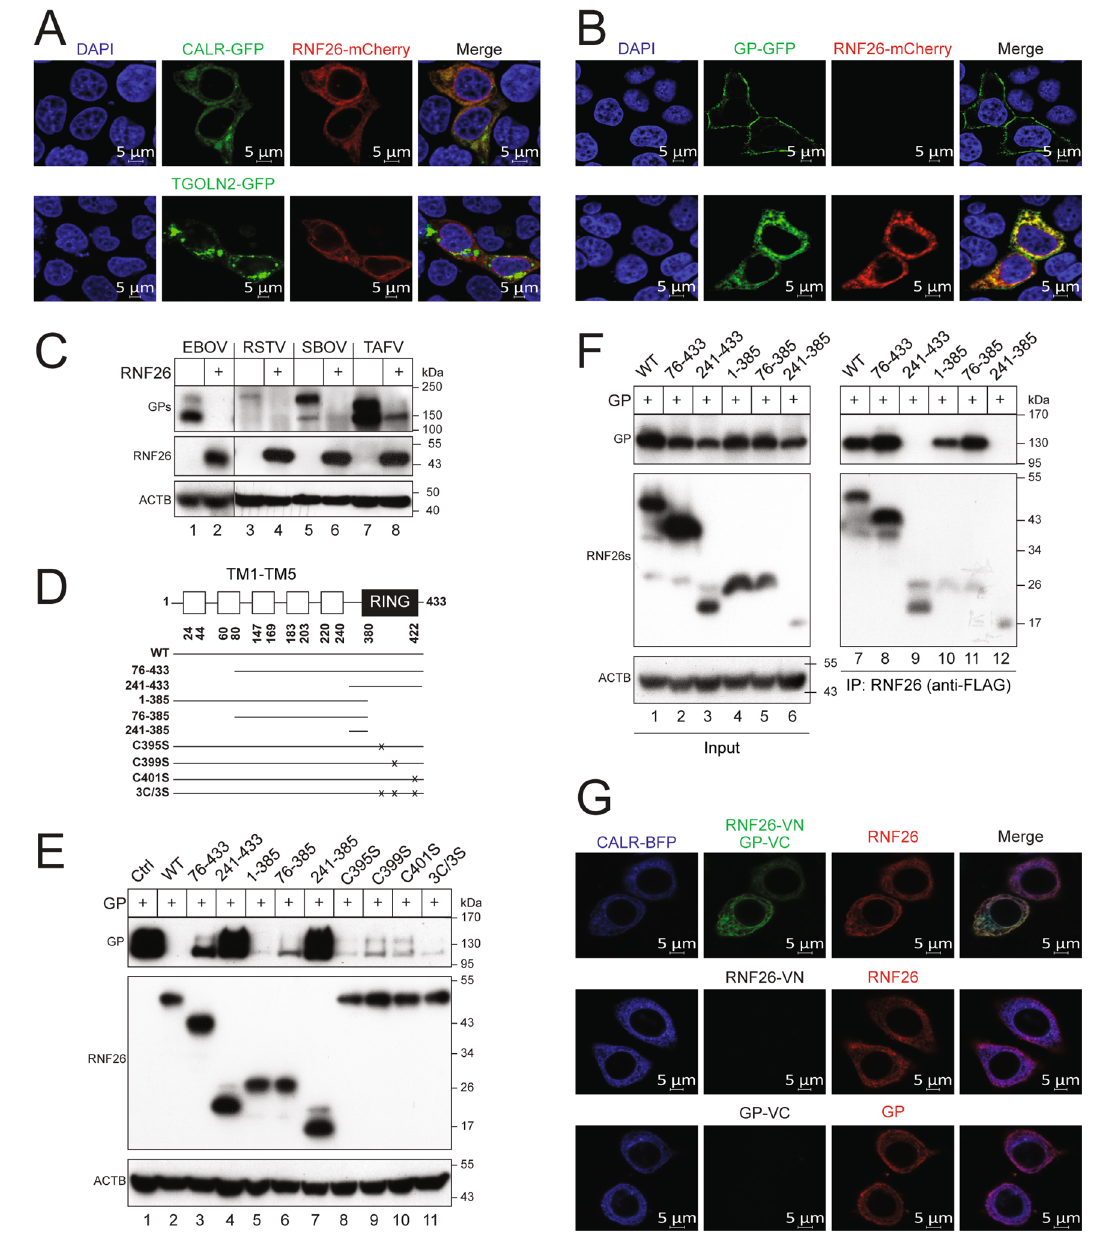
Fig. 5 | RNF26 decreases EBOV-GP 1,2 expression in an E3 ubiquitin ligase activity-independent manner. A RNF26 with a C-terminal mCherry tag was expressed with CALRor TGOLN2(Trans-Golginetworkintegralmembrane protein 2) that has a GFP-tag in HeLa cells. The RNF26 subcellular localization was deter- mined by confocal microscopy. B EBOV-GP 1,2 (GP) with a C-terminal GFP tag was expressed with RNF26-mCherry in HeLa cells, and their co-localization was deter- mined by confocal microscopy. C GP 1,2 proteins from indicated ebolaviruses were expressed with RNF26 in HEK293T cells. Protein expression was detected by WB. GPs were detected by anti-EBOV-GP; RNF26 was detected by anti-FLAG. D A sche- matic diagram of RNF26 is presented on the top. Five transmembrane (TM1 – TM5) domains and a RING- fi nger are shown. Five RNF26 deletion mutants that target indicatedregionsandfourpoint-mutationmutantsthattargeteachof C395,C399,